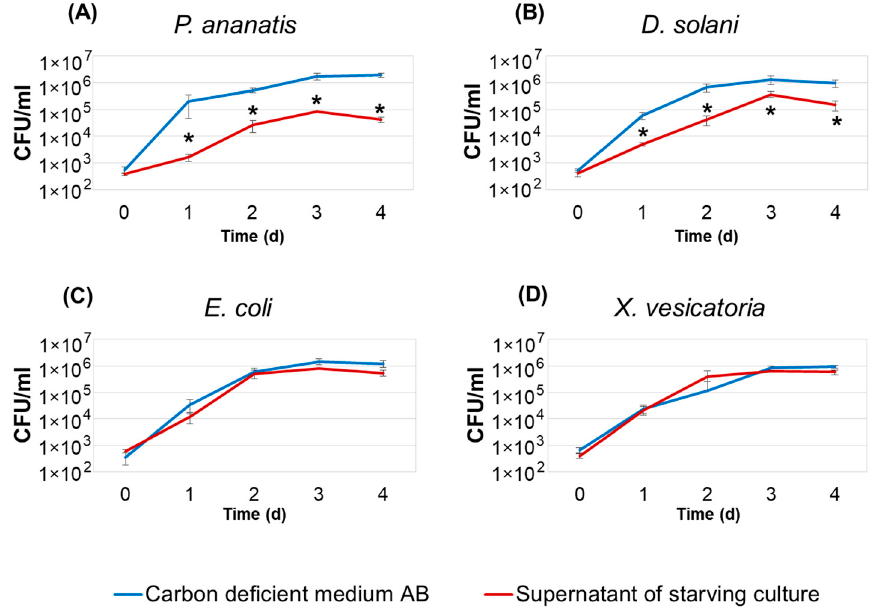
Figure 7. The effect of the supernatants of the Pectobacterium atrosepticum starving cultures that passed through adaptive proliferation on the adaptive proliferation of Pantoea ananatis ( A ), Dickeya solani ( B ), Escherichia coli ( C ), and Xanthomonas vesicatoria ( D ). Cultures were incubated at low initial population densities in either a fresh carbon-deficient medium (blue line) or supernatants of P. atrosepticum starving cultures (red line). The presented values are the means ± SD of three biological replicates. Asterisks (*) show a significant difference (Mann–Whitney two-sided test, p < 0.05) between the colony forming unit (CFU) titers in cultures incubated in a fresh carbon-deficient medium vs. that in cultures incubated in the supernatants of the P. atrosepticum starving